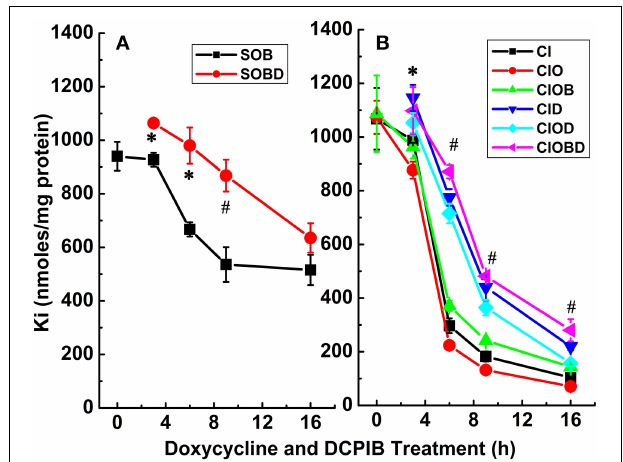
FIGURE 6 | Constitutive KCC3 Thr991/Thr1048 dephosphorylation elicits rapid and potent cellular K i loss which is time-dependent and partially sensitive to DCPIB. K i content was measured as described in Materials and Methods during induction with doxycycline (1 µ g/ml) and in the presence and absence of DCPIB (50 µ M). (A) K i content in Cl-free medium, sulfamate (S) replacement without (SOB, black squares) and with DCPIB (SOBD, red circles). (B) K i content in Cl-media ± ouabain (0.1mM) ± bumetanide (10 µ M) without (Cl, ClO and ClOB, black squares, red circles, and green triangles, respectively) and with DCPIB (ClD, ClOD and ClOBD, blue triangles point down, cyan diamonds, and magenta triangles point left, respectively). Mean ± SE, n = 3 –6 individual determinations. (A) For SOB vs. SOBD, there was a statistically significant difference between groups as determined by One-Way ANOVA [ F (8 , 21) = 51 . 65 , p < 0 . 0005 , n = 30 ], and confirmed by paired t -test, * p ≤ 0.01 at 3 and 6h and # p ≤ 0.005 at 9h. (B) For Cl, ClO, ClOB vs. ClD, ClOD, ClOBD, respectively, there was a statistically significant difference between groups as determined by Kruskal–Wallis One–Way ANOVA [ F (8 , 21) = 64 . 42 , 77.64, and 45.44, p < 0 . 0005 , n = 30 ], and confirmed by paired t -test, * p < 0 . 05 at 3h and # p < 0 . 005 at 6 and 9h. Data represent the mean ± SEM values. Representative results from 4